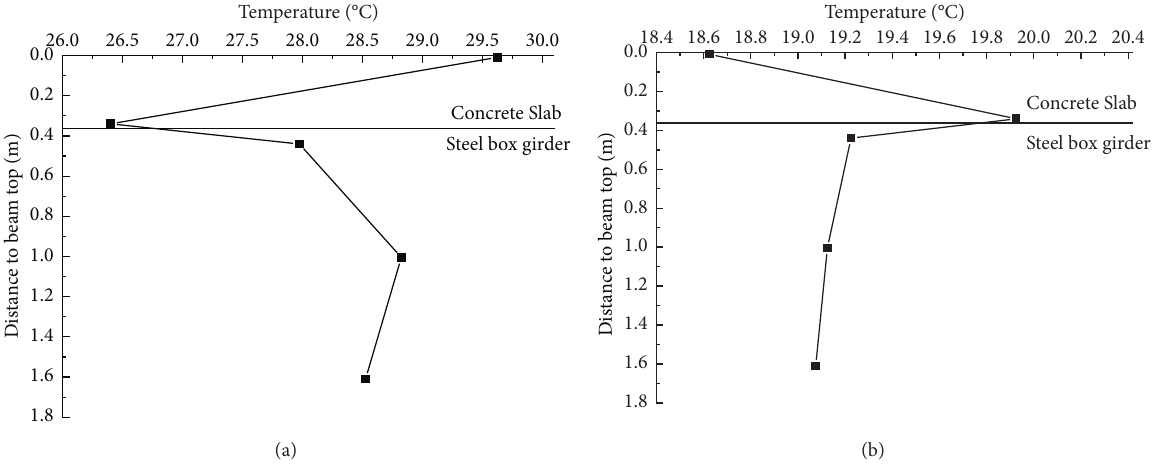
Figure 12: Most unfavourable curves of the temperature gradient on the vertical section. (a) Rise gradient after average. (b) Drop gradient after